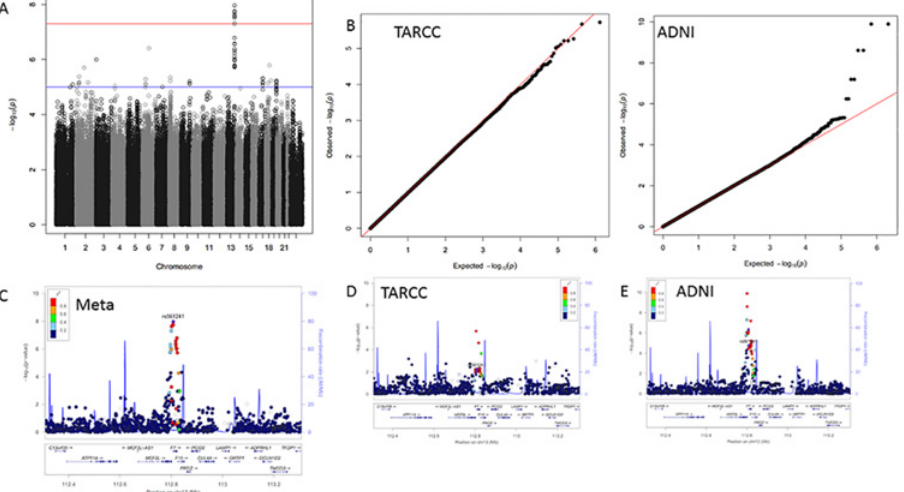
Fig 2. Factor VII results. Panel A; GWAS Manhattan plot for the meta-analysis of Factor VII. Panel B; QQ plots for the association results for TARCC (left) and ADNI (right). Panel C; LocusZoom plot for the chromosome 13 signal observed in the meta-analysis. Panels D and E; LocusZoom plots for the chromosome 13 signal in TARCC and ADNI,